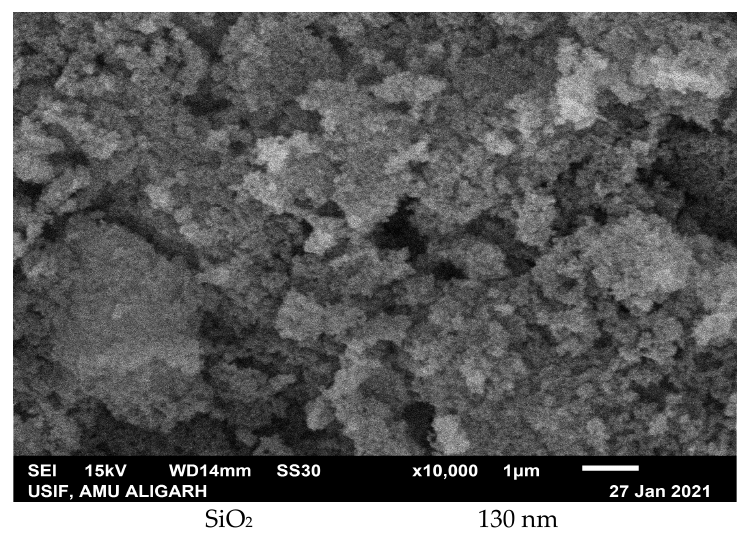
Figure 1. SEM image of SiO 2 nanoparticles.